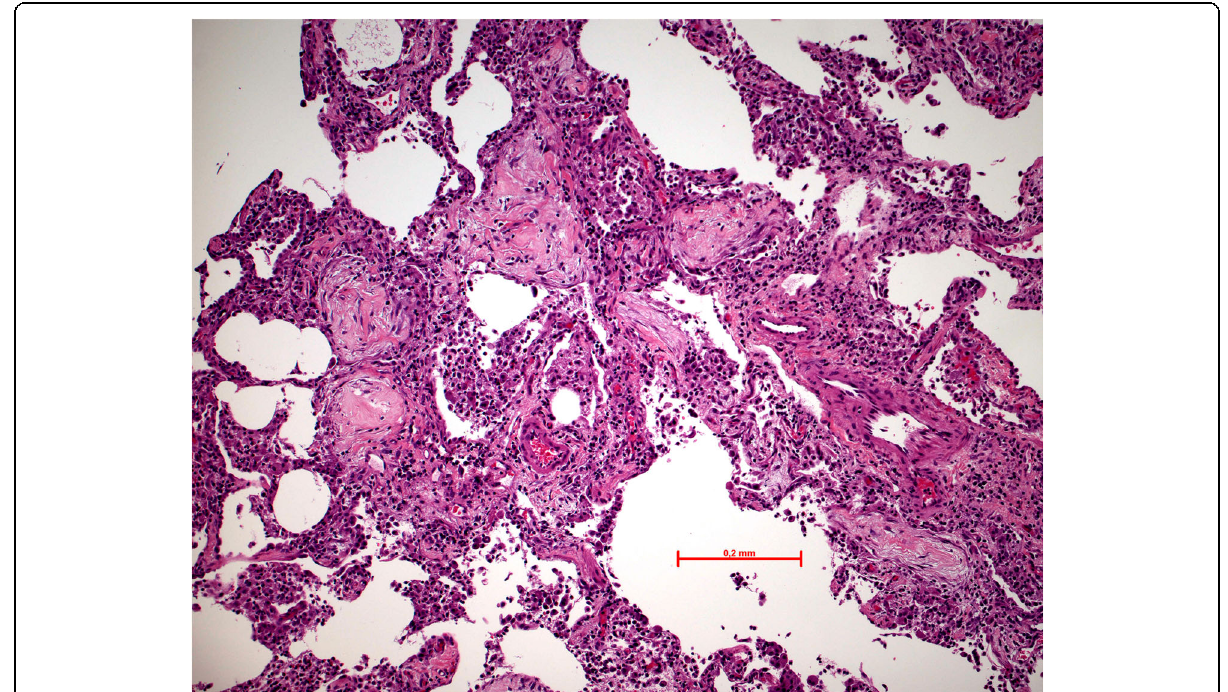
Fig. 22 Organizing pneumonia with many granulation polyps; note the newly formed blood vessels within these polyps. H&E, bar 200 μ m